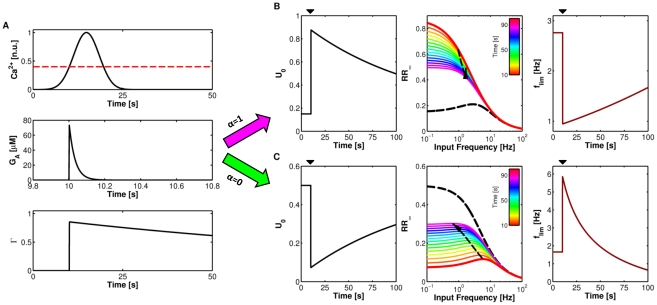
Mechanism of astrocyte regulation of synaptic release.(A, top) When intracellular Ca2+ increases beyond the threshold value for exocytosis (dashed red line), the astrocyte releases an amount of glutamate into the extrasynaptic space (black mark, middle). The resulting fast transient increase of extracellular glutamate activates presynaptic receptors which, depending on the “effect” parameter α in our model, can decrease (C, α = 0) or increase (B, α = 1) the synaptic basal release probability U
0. Mean-field analysis predicts that steady-state evoked synaptic glutamate release () is respectively diminished (C, middle) or increased (B, middle) (colored lines, snapshot color codes for the time after release of astrocytic glutamate) with respect to the case without astrocytic glutamate (dashed black line). (B,C, right) Equation (4) allows to elucidate how the limiting frequency (f
lim) of the synapse changes under astrocyte signaling. Parameters as in Table S1.